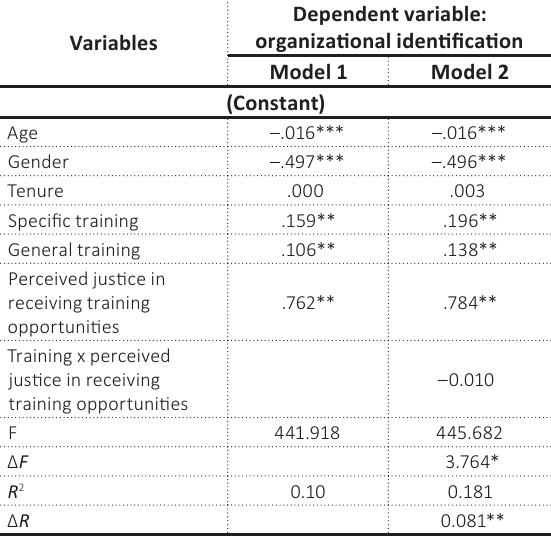
Table 3. Results of regression analysis of organizational identification (moderating